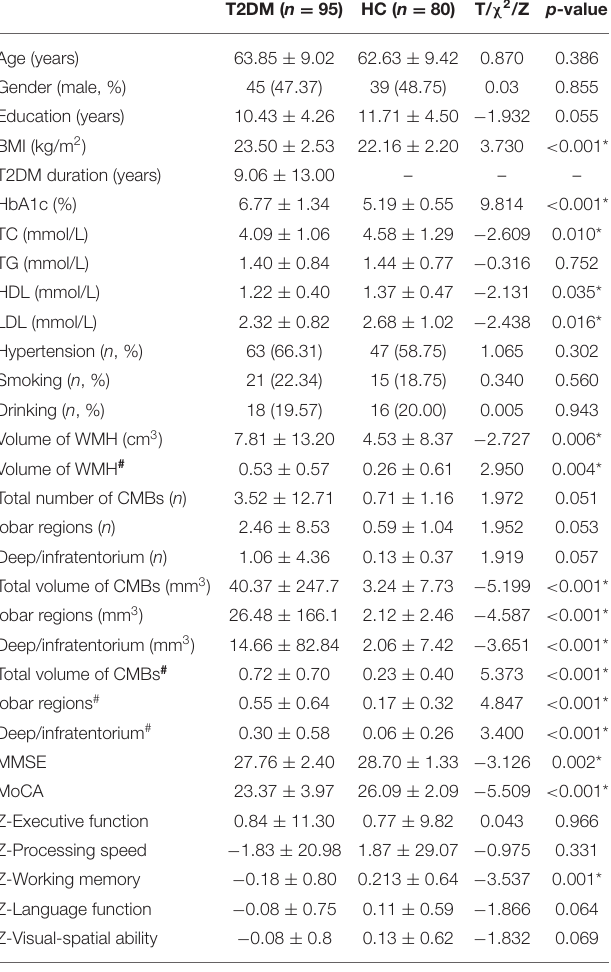
TABLE 2 | Clinical data for all subjects.